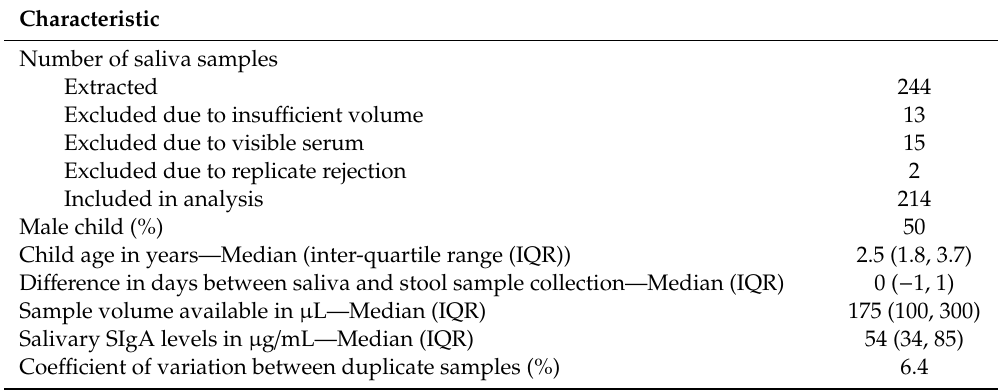
Table 1. Summary